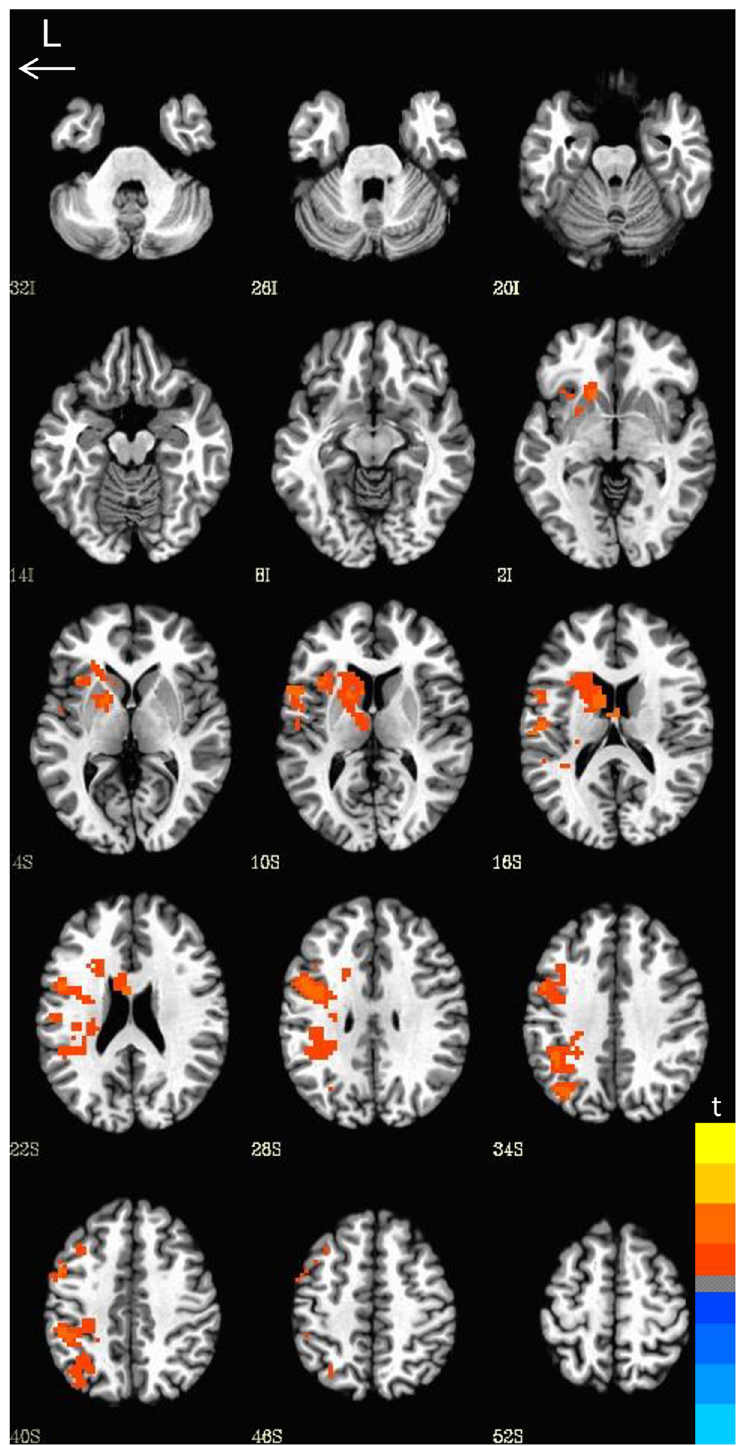
Fig 4. Neural activation by Condition. Comparison of neural activation during word versus pseudoword reading. Greater activation was observed for pseudowords relative to words.